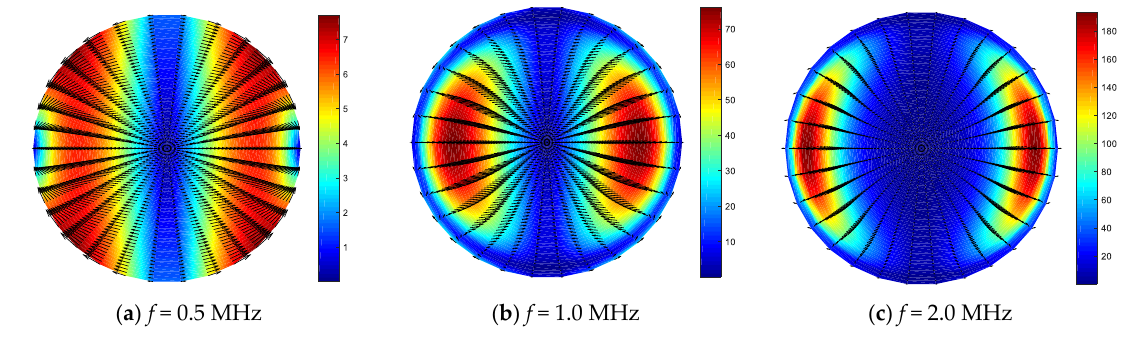
Figure 8. F d (1,1) Poynting vector at each frequency.